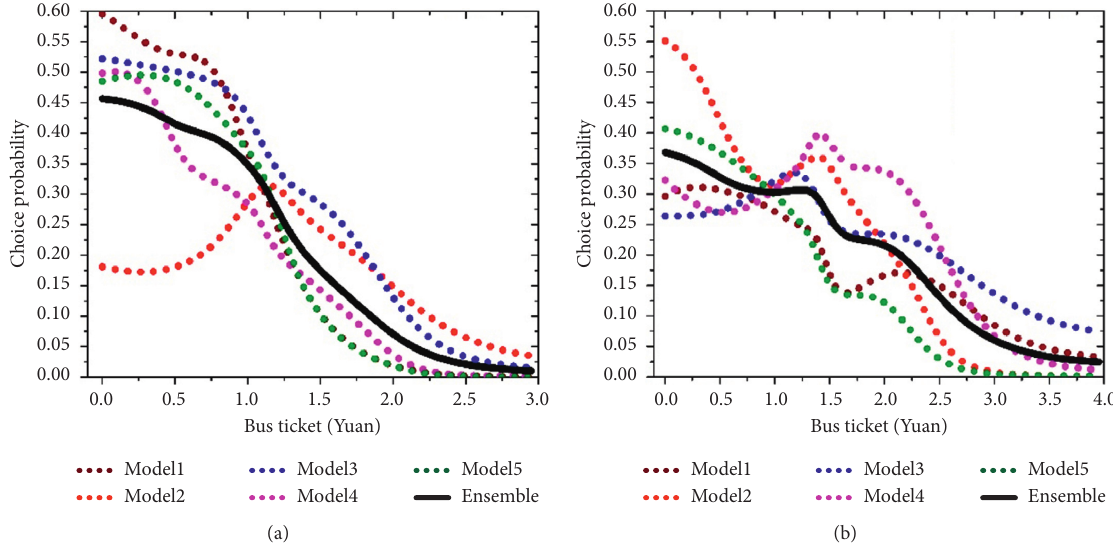
Figure 8: Variation curve of the bus choice probability with the bus ticket. (a) Short trip. (b) Long